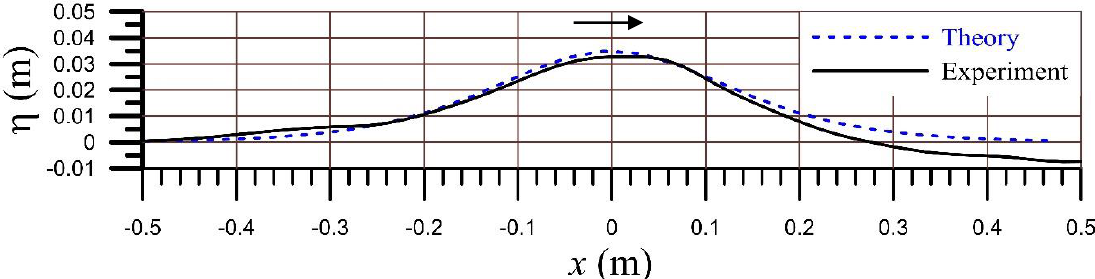
Figure 4. Comparison of measured waveform with the theoretical one.